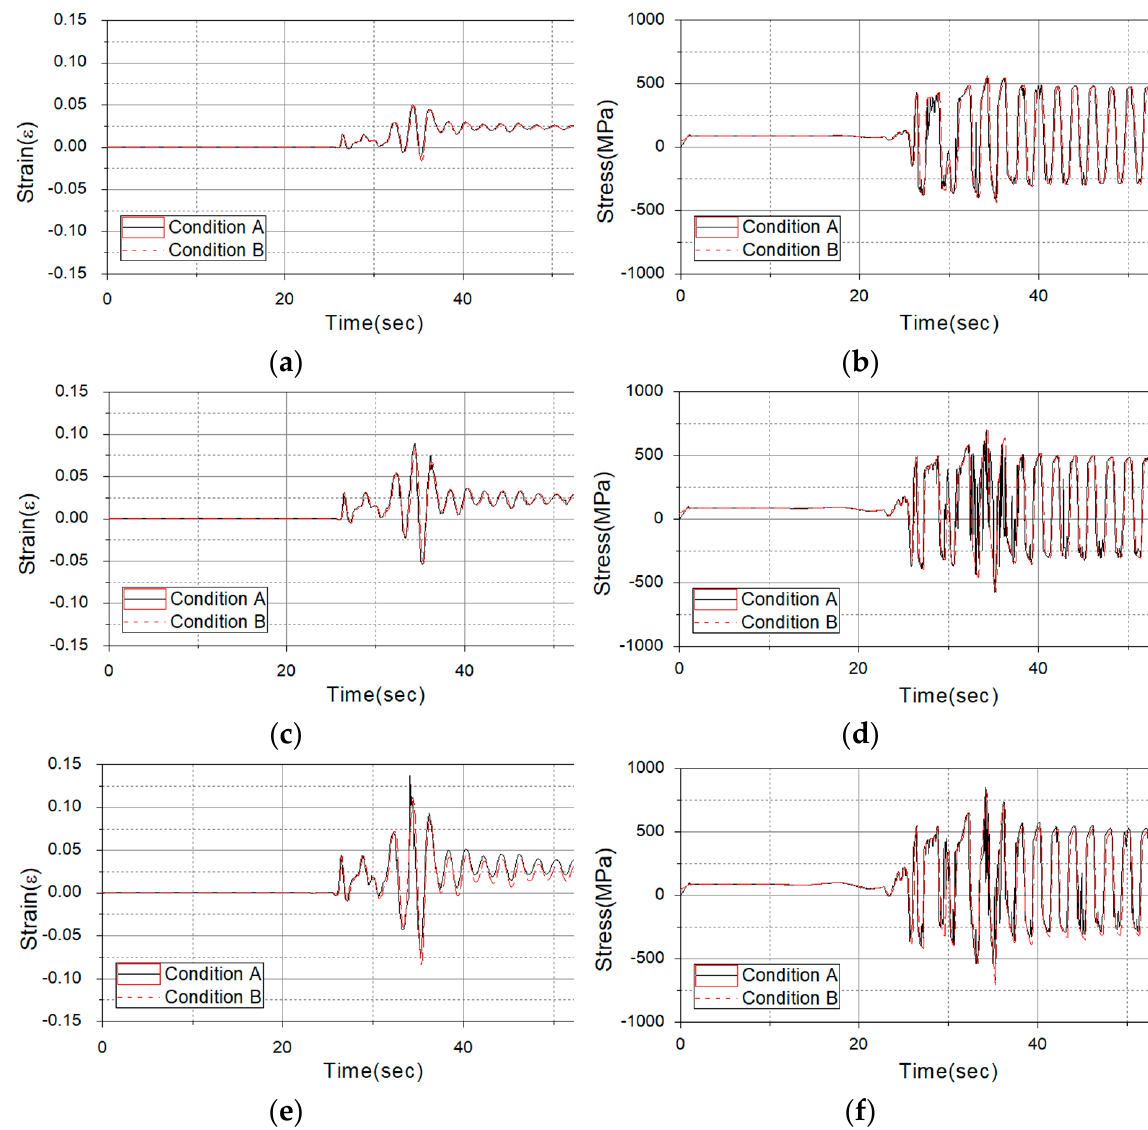
Figure 13. Comparison of the convergence “condition A” and convergence “condition B” analysis results (Northridge earthquake): ( a ) comparison of the stress (PGA level: 1 g); ( b ) comparison of the strain (PGA level: 1 g); ( c ) comparison of the stress (PGA level: 2 g); ( d ) comparison of the strain (PGA level: 2 g); ( e ) comparison of the stress (PGA level: 3 g); ( f ) comparison of the strain (PGA level: 3 g).